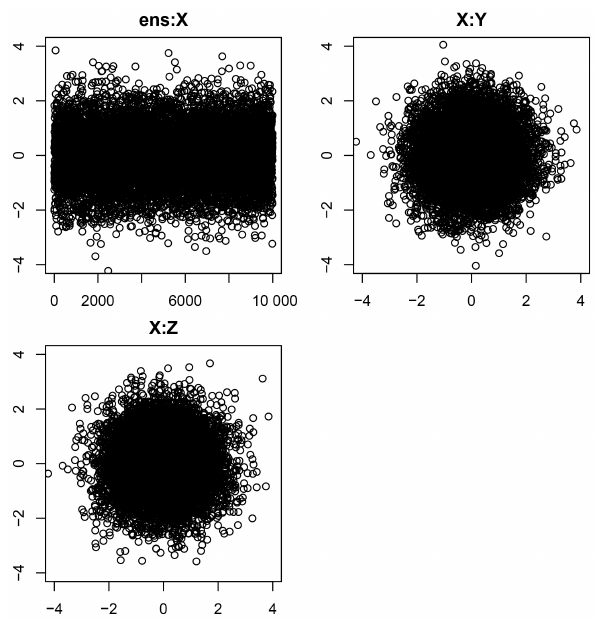
Figure A1. 10000 initial conditions for calculation of the ensem- ble Lyapunov exponent. (a) The distribution of X as a function of the ensemble members. (b) The distributions of X and Y . (c) The distributions of X and Z .